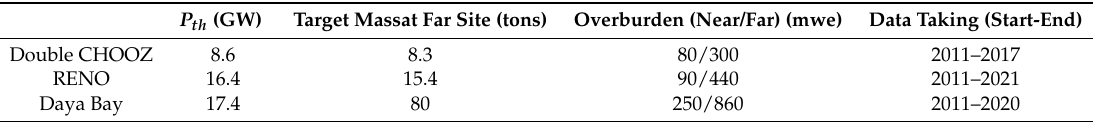
Table 1. Comparison of the main parameters of Daya Bay, Double CHOOZ and RENO. Table taken from [46].